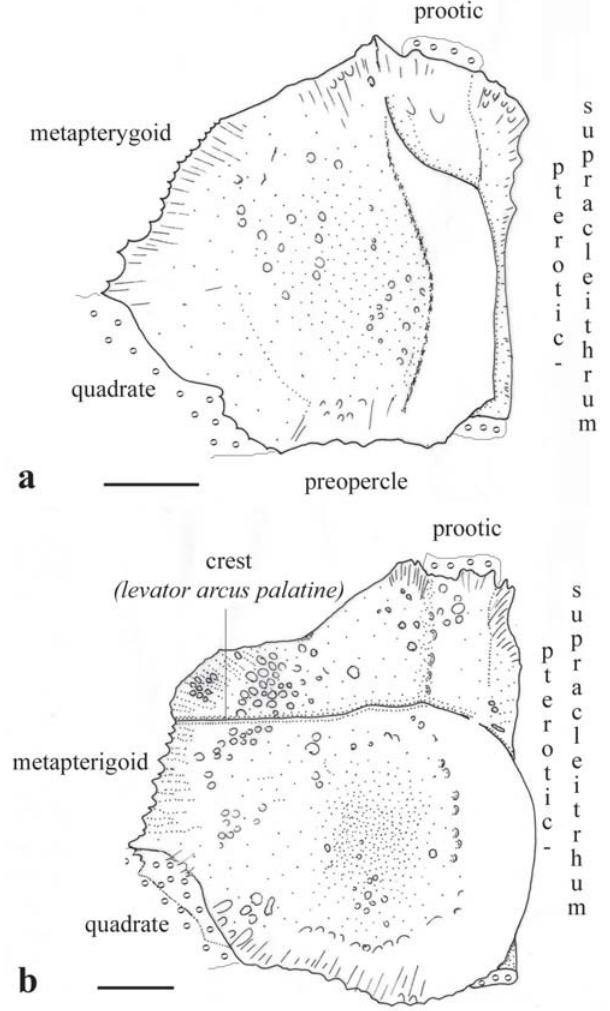
Fig. 34. Dorsal view of the hyomandibula (left side) of Pterosturisoma microps (MZUSP 79909, 75.9 mm SL) (a), and Lamontichthys filamentosus (LACM 41741-9, 119.4 mm SL) (b). Bones that articulate with the hyomandibula are indicated around the illustration. Scale bar = 1